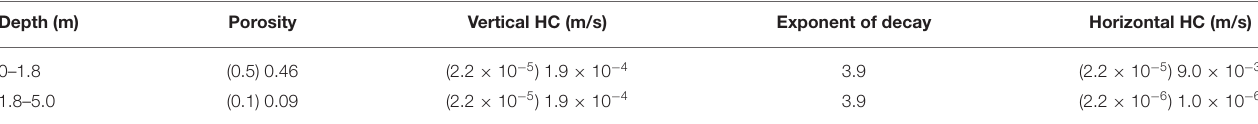
FIGURE 1 | Map depicting the South Fork of Caspar Creek sub-watersheds, stream temperature stations, precipitation stations, meteorological station, weir, watercourse classes, simulated reaches, simulated target harvest rates and where the South Fork of Caspar Creek Watershed is in relation to the Arcata Cloud Cover Station, Windsor CIMIS station and Blythe, CA comparison location. Map data sources: California Department of Forestry and Fire Protection, ESRI USA. The map created used ArcGIS ® software by Esri. ArcGIS ® is the intellectual property of Esri and are used herein under license. Copyright © Esri. All rights reserved. For more information about Esri ® software, please visit www.esri.com. TABLE 1 | A priori and calibrated parameters for the South Fork 2011–2016 HY. Depth (m) Porosity Vertical HC